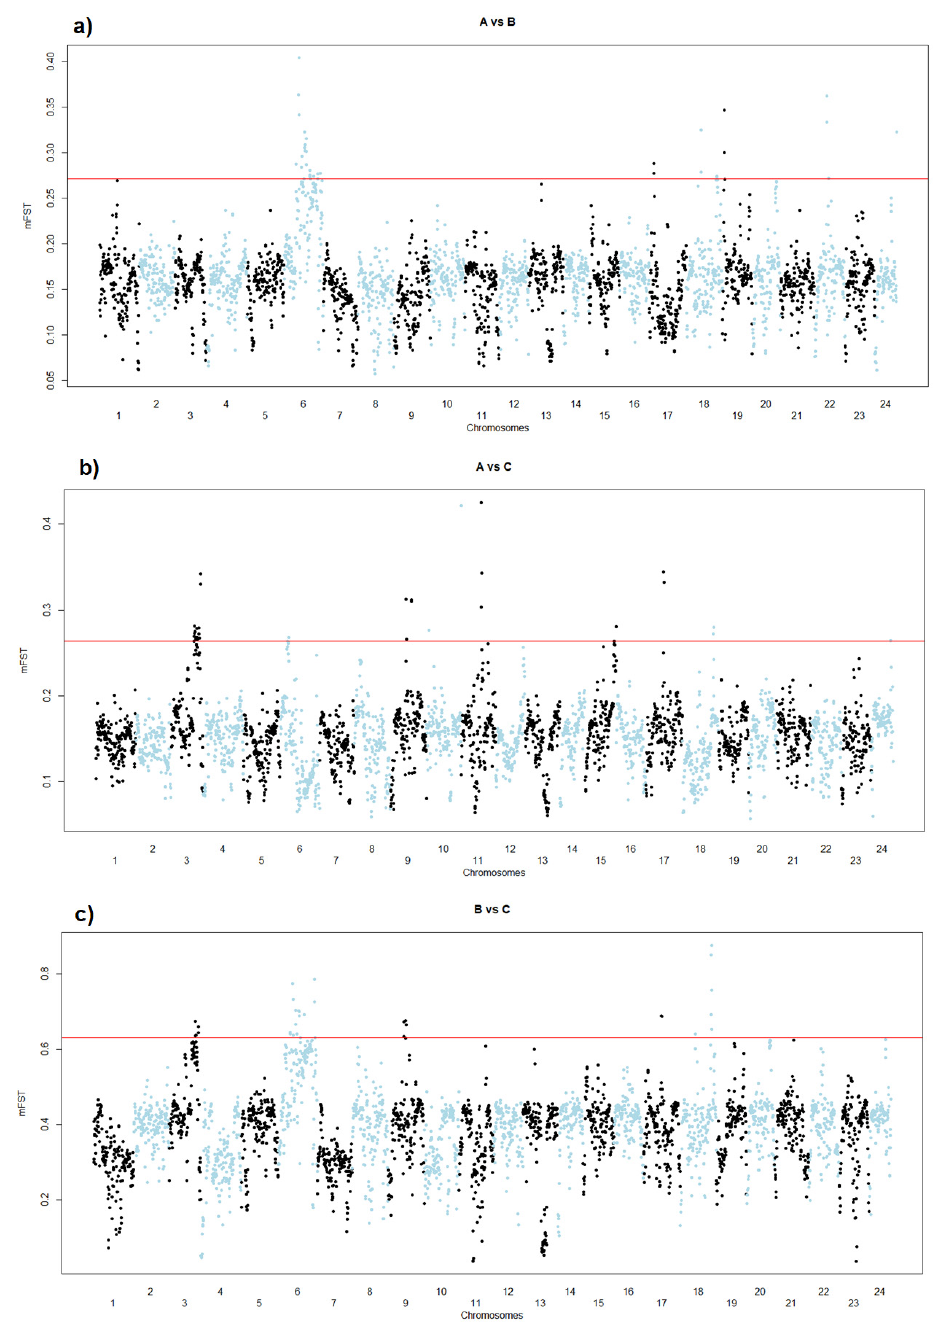
Figure 3. Manhattan plots of the m FST values observed in the pairwise analyses between the DNA pools constructed from the fry of the three different nuclei cultivated in the Italian hatchery: ( a ) DNA pool A vs. DNA pool B; ( b ) DNA pool A vs. DNA pool C; and ( c ) DNA pool B vs. DNA pool C.